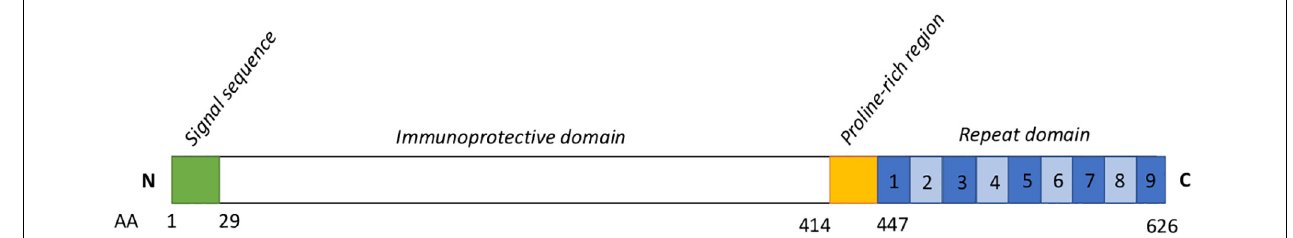
FIGURE 1 | Schematic representation of the SpaA protein sequence. Based on To and Nagai, 2007. Numbers below indicate amino acid (AA) positions. Numbers within the blue boxes represent the typical number of repeat units. The signal sequence (AA 1-29) is thought to be associated with the secretion mechanism for this protein. The immunoprotective domain (AA 30-413) is the component conferring immunogenicity, and upon which typing schemes for SpaA have been developed. The role of the proline-rich region (415–447) has not been well described. Seven to 13 repeats of a 20-AA sequence containing a GW module make up the C-terminal domain of SpaA; these have a role in binding the SpaA protein to the bacterial cell surface. TABLE 1 | Surface proteins of Erysipelothrix rhusiopathiae with a suspected role in immunogenicity. Locus tag Nucleotide Amino acid Gene Name/Description (former) Positions a length